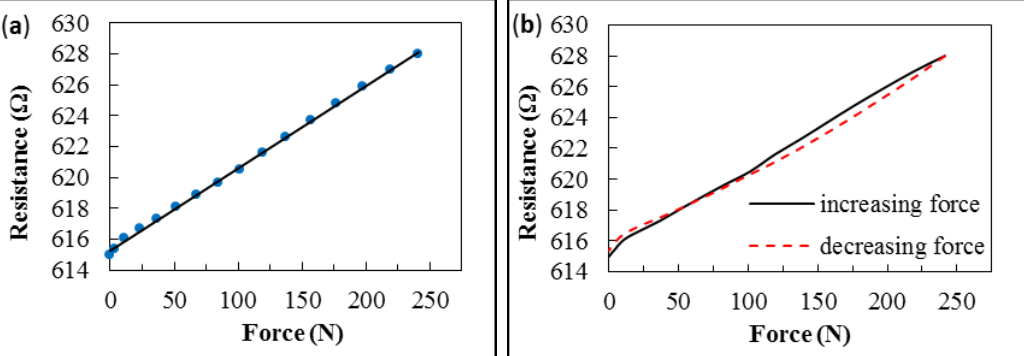
Figure 7. Resistance–force characteristic of a strain gauge embedded in a silicone O-ring. ( a ) Nearly linear response while increasing force; ( b ) Hysteresis during the first strain